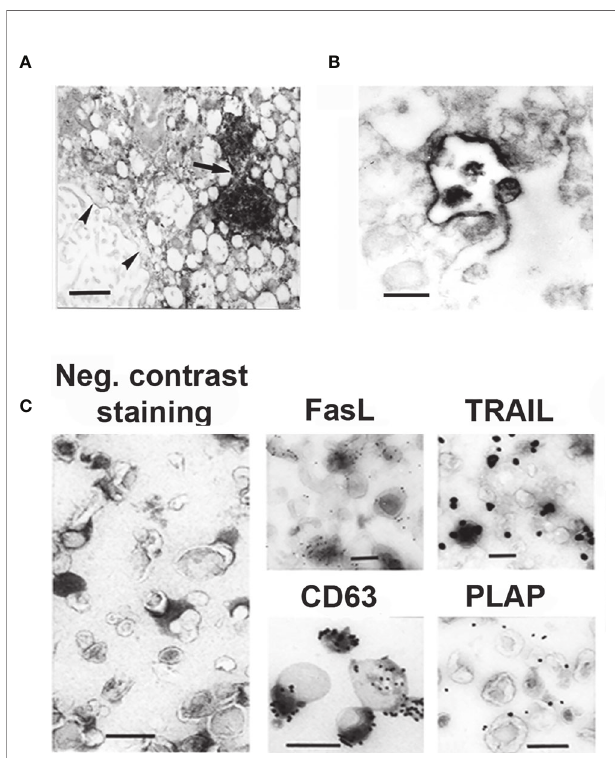
FIGURE 2 | EM and IEM micrographs showing IHC- (A, B) and immunogold (C) staining of syncytiotrophoblast and isolated exosomes. (A) Syncytiotrophoblast stained for FasL. (B) Exocytotic MVB, stained for TRAIL, opens up and releases exosomes into the extracellular space. (C) Isolated STB exosomes, stained by negative contrast, showing their morphology, and stained by immunogold, showing FasL and TRAIL expression on their surface. Anti-CD63 staining identi fi es that the isolated extracellular vesicles are exosomes, and anti-placental alkaline phosphatase (PLAP) staining veri fi es that the exosomes have STB origin. Arrow points at two MVB fi lled with FasL stained exosomes. Arrowheads point at FasL stained perinuclear membranes. Bars represent 100 nm. Reproduced with copyright permission from ref.